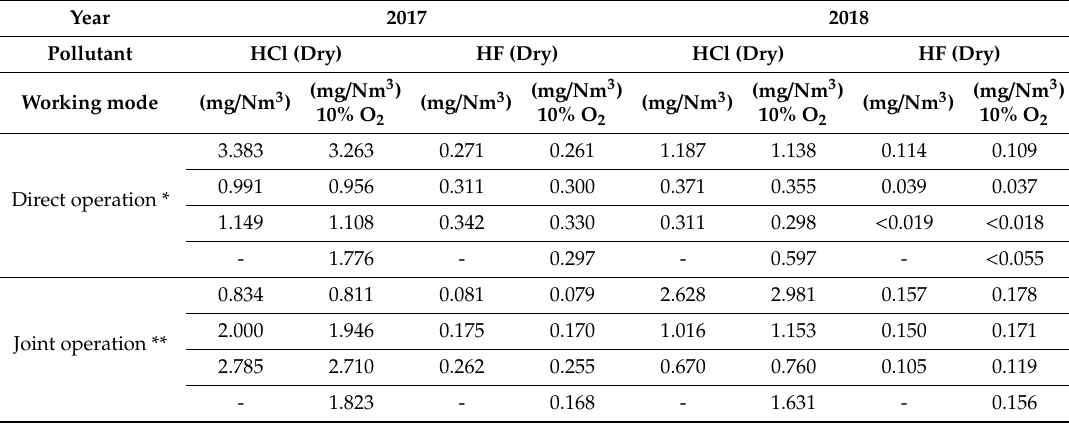
Table 2. Measurement results of HCl and HF of the rotary kiln at first cement factory, Romania, for 2017 and 2018.